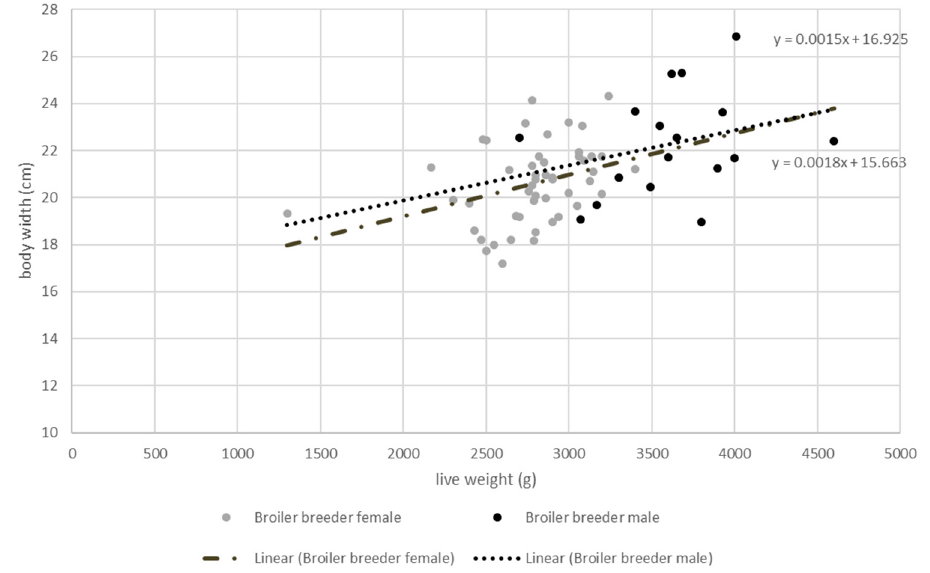
Figure 2. Body width (mm) of female ( n = 50) and male ( n = 17) 22-week-old broiler breeders (Ross 308) depending on their live weight (g).